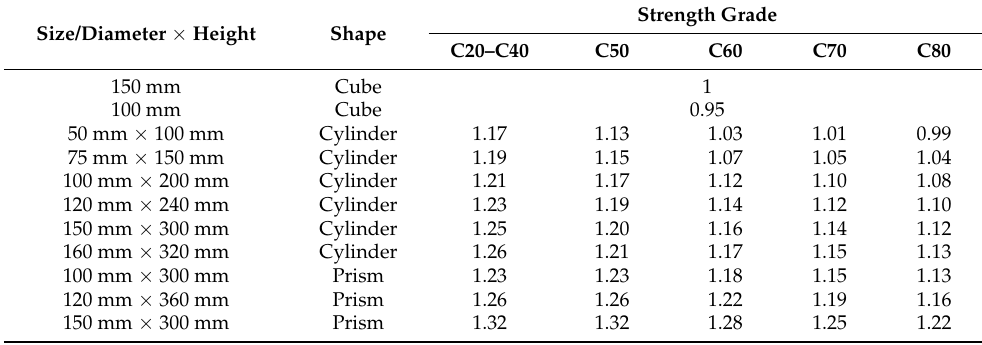
Table 1. Conversion factors of compressive strength [13–16].